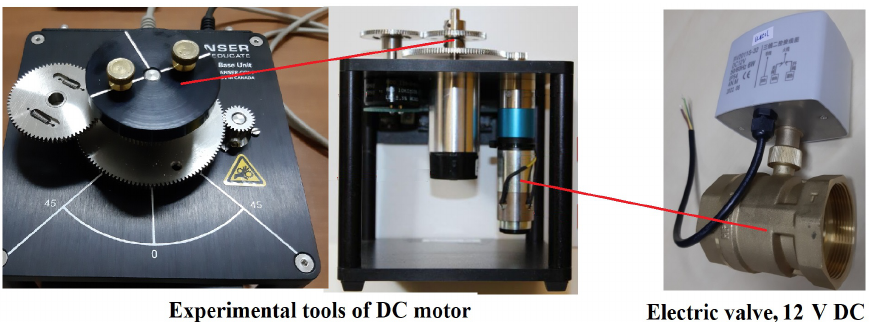
Figure 3. Instrument of DC motor as experimental design